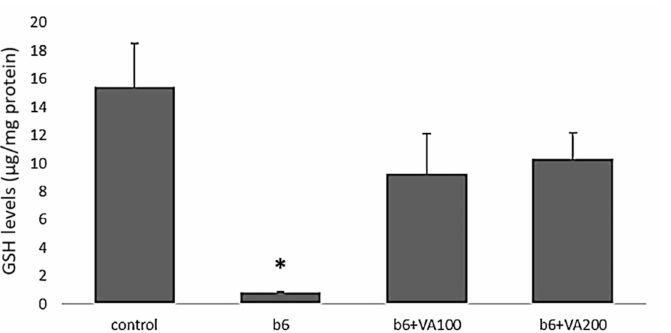
Figure 5. The effects of benomyl and benomyl accompanied by two concentrations of VA (100 and 200 µ M) on the GSH levels of the cells. B6: exposure to 6 µ M benomyl; VA100: exposure to 100 µ M valerenic acid; VA200: exposure to 200 µ M valerenic acid (* statistically significant difference compared to the